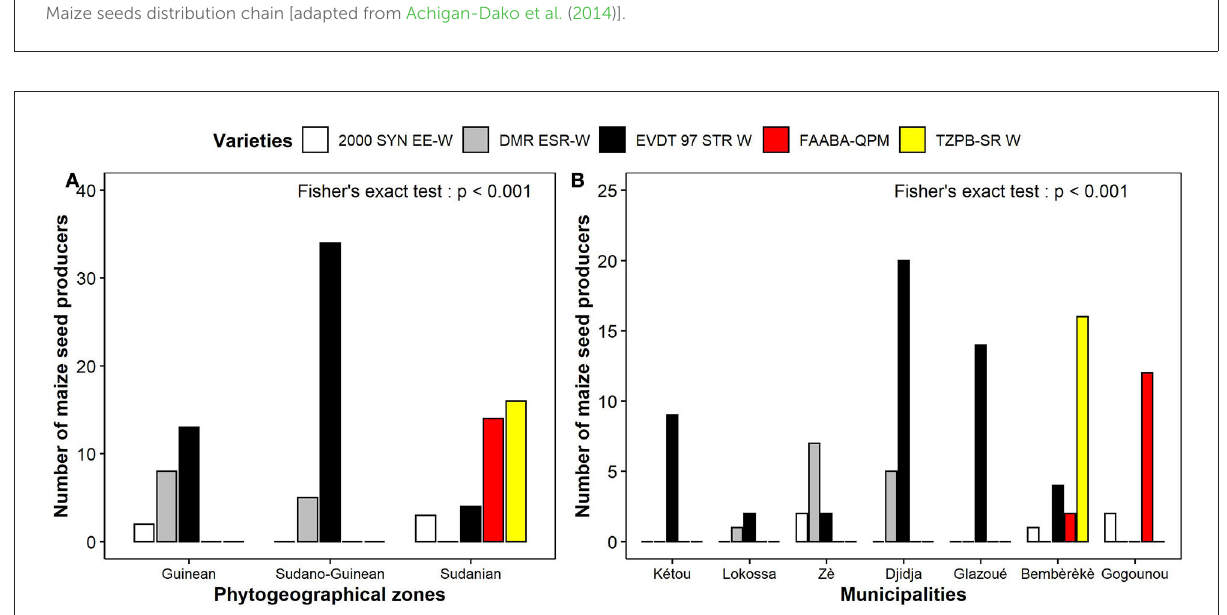
FIGURE3 Number of maize seed producers growing given maize seed varieties across phytogeographical zones (A) and municipalities (B) .